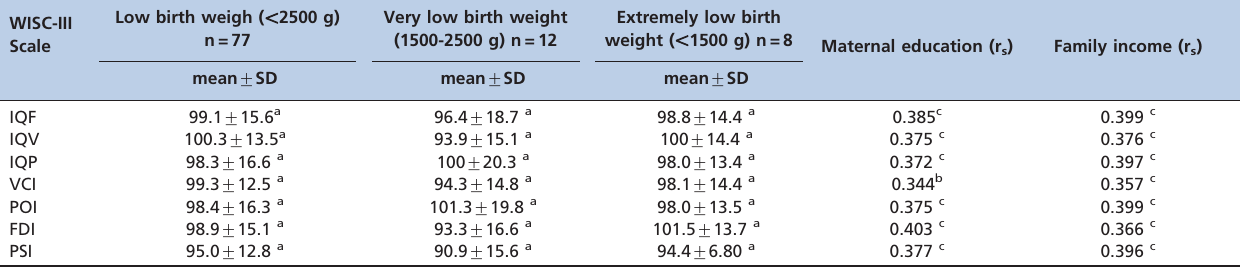
Table 2 - Performance on the WISC-III scale and its association with birth weight, maternal education and family income (n = 97).